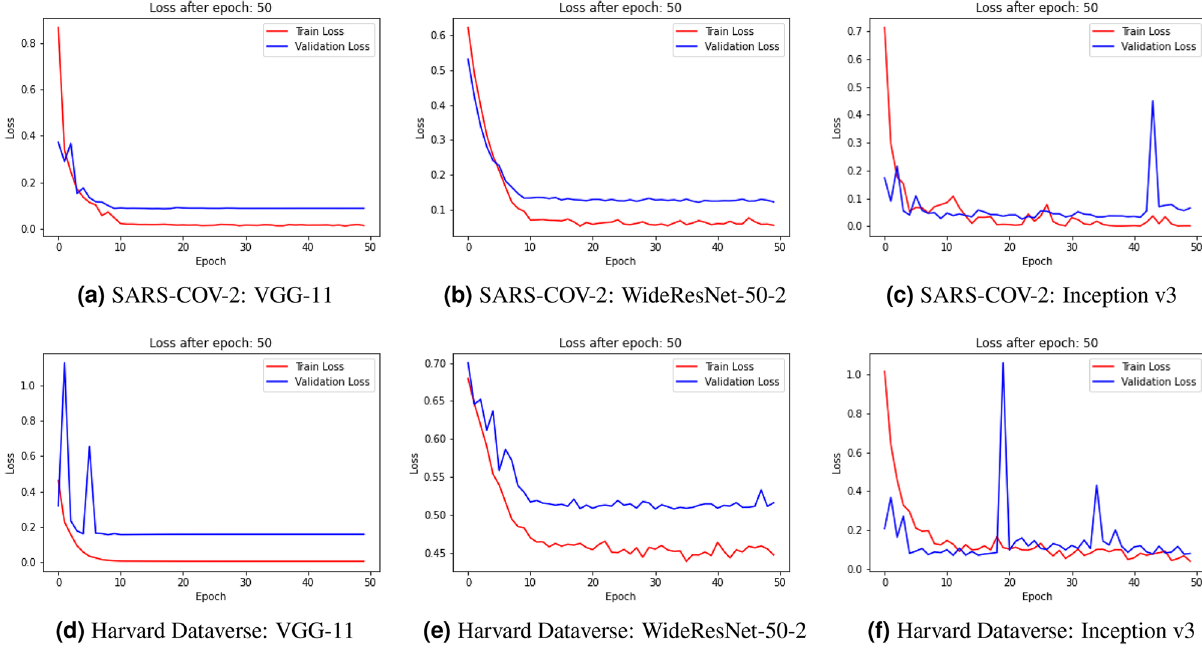
Figure 5. Loss curves obtained on the two datasets used in this research by the base learners used to form the ensemble. ( a )–( c ) shows the loss curves on the SARS-COV-2 dataset and ( d )–( f ) shows the loss curves on the Harvard Dataverse dataset.